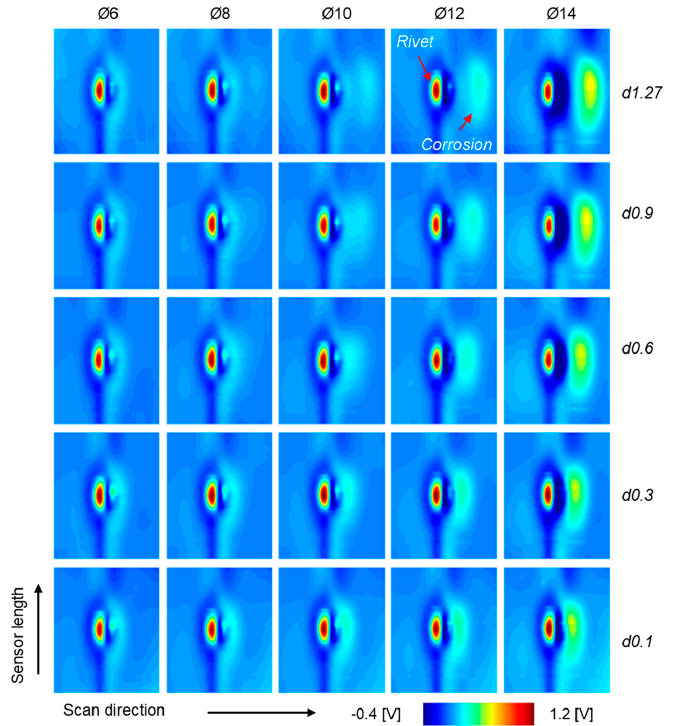
Figure 4. Sample scanned images of five different types of rivets: no corrosion, backward corrosion, forward corrosion, left corrosion, and right corrosion ( Ø 10 × d0.9).